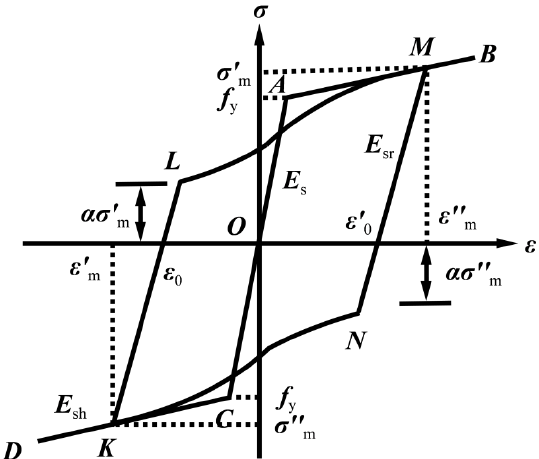
Figure 6. Present hysteretic model of bar.